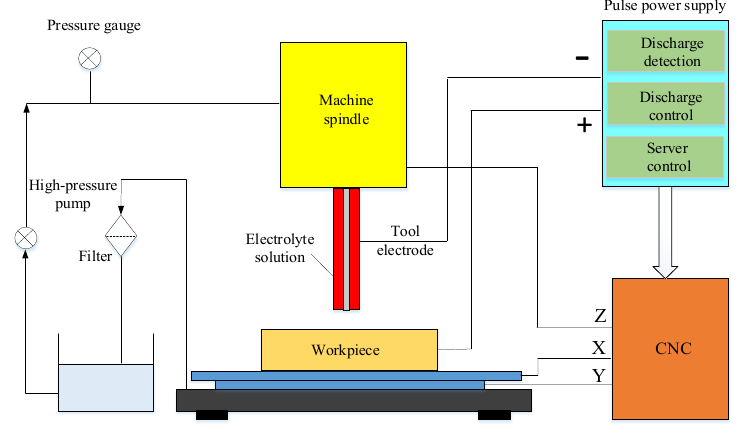
Figure 13. Schematic diagram of ECM system.